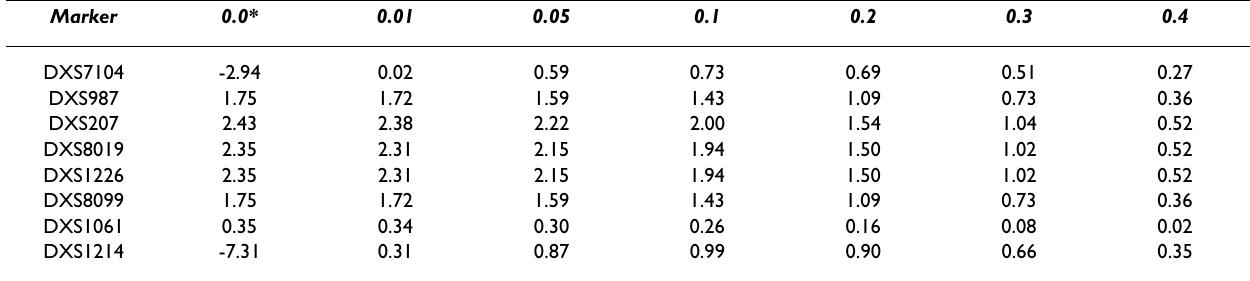
Table 2: Two-point LOD scores analysis across the markers DXS7140 and DXS1214 linking MRX87 family to Xp22-p21 interval